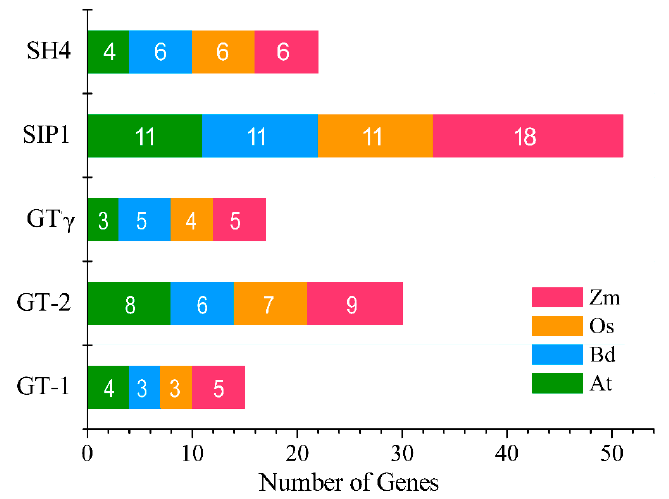
Figure 5. The distribution of GT genes in Arabidopsis , maize, rice and B. distachyon . The total number of SH4, SIP1, GT γ , GT-2, and GT-1 subfamily genes found in each genome is indicated in the bar.